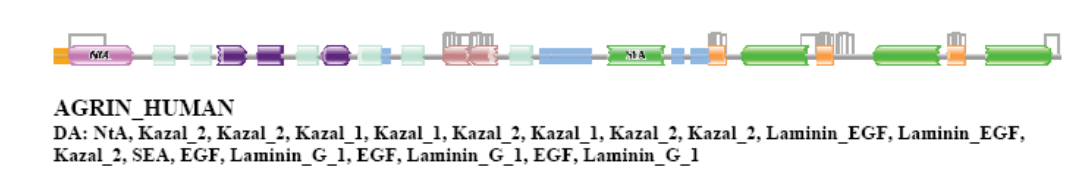
Figure S8. Comparison of the domain architecture of AGRIN_HUMAN with that of its closest paralog.